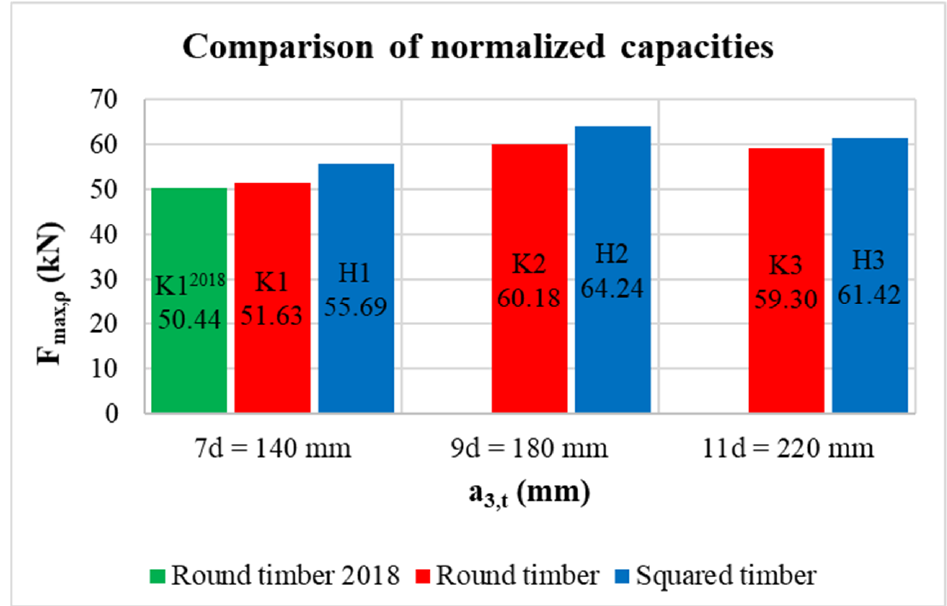
Figure 21. Comparison of the normalized load-carrying capacities for all types of specimens.